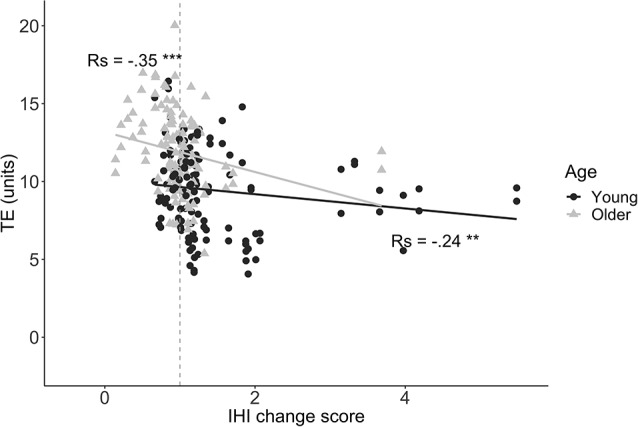
Tracking Error (TE) during the first 1.5 s of movement execution is plotted against IHI change scores (IHIprepIHIbase), for young (dots) and older (triangles) adults. A negative correlation indicates that greater DLPFC-M1 IHI change during motor preparation is related to lower TE (i.e., better performance). The dashed line corresponds to an IHI change score of 1. Values below 1 indicate more inhibition in the late preparatory period as compared to baseline. Values above 1 indicate less inhibition (i.e., disinhibition) in the late preparatory period as compared to baseline. Abbreviations: TE, Tracking Error; Rs, Spearman’s rank correlation coefficient; **p < 0.01; ***p < 0.001.